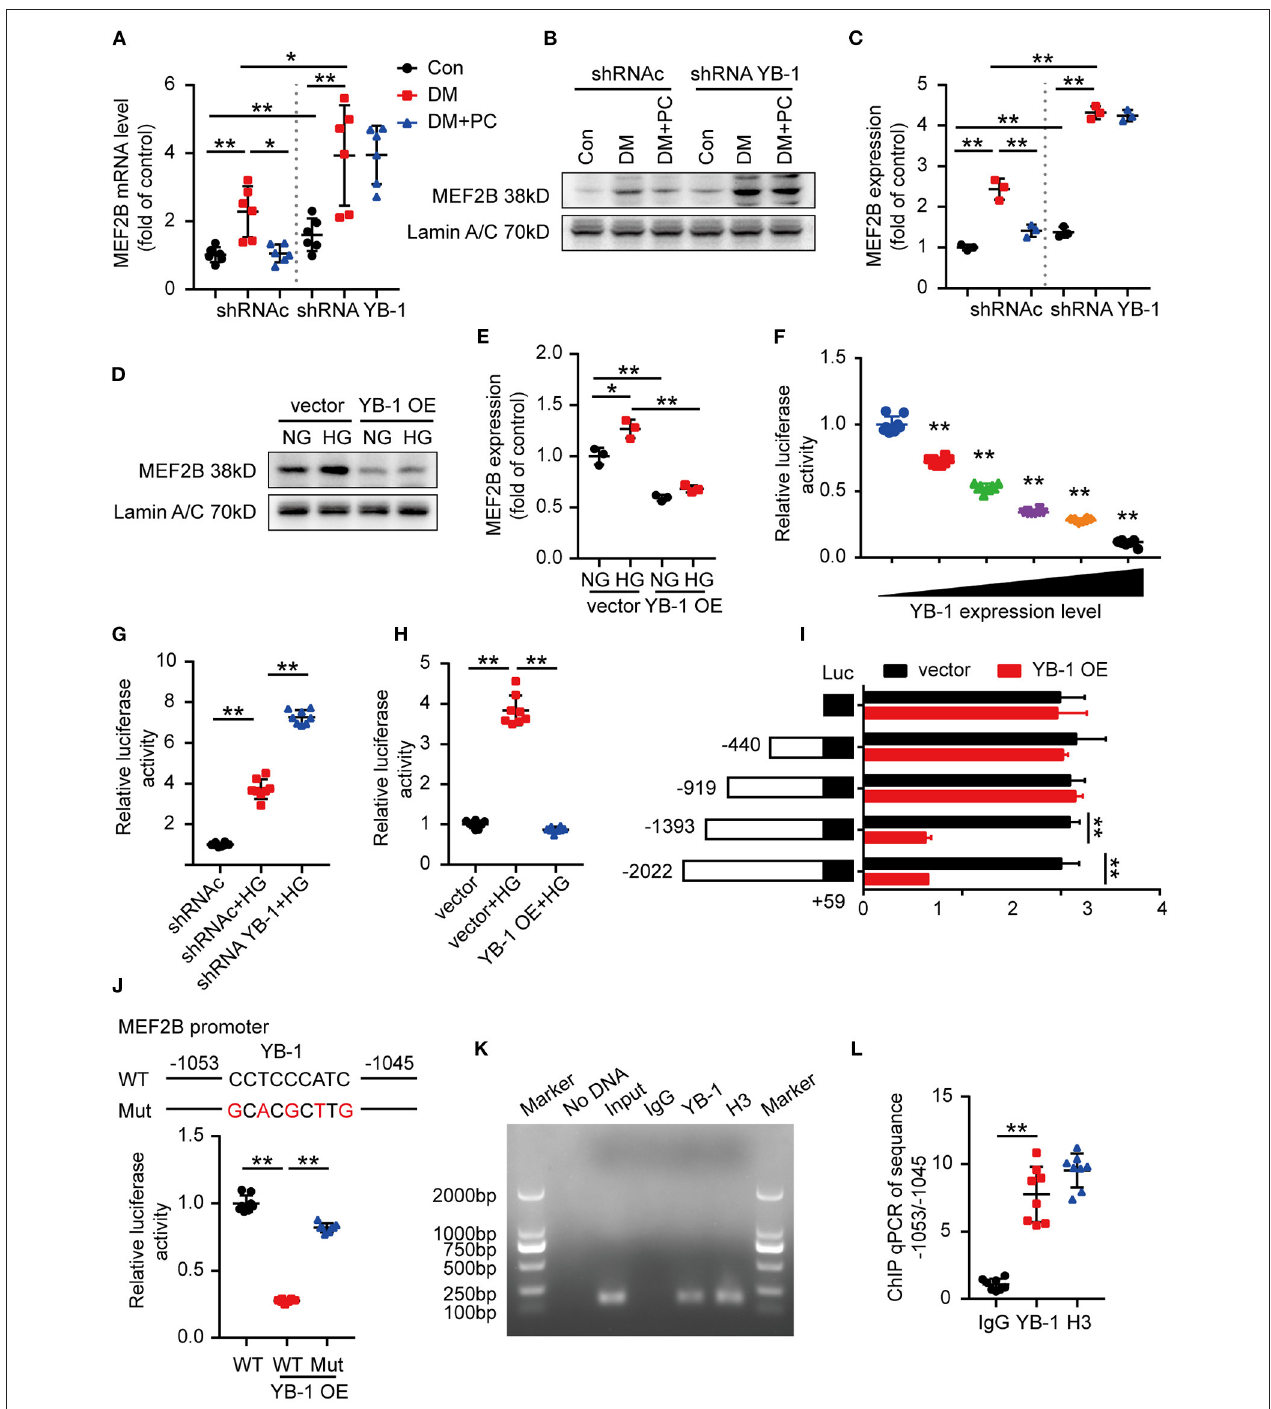
FIGURE 3 | YB-1 may regulate cardiac function via MEF2B. (A) MEF2B mRNA level in mouse heart tissues detected by real-time qPCR. n = 6 for each group. (B,C) Representative western blots and scatter blots showing MEF2B nuclear protein level in mouse heart tissues from indicated experimental groups. (D,E) Representative immunoblotting and scatter blots demonstrating MEF2B nuclear protein level in H9c2 cells with or without YB-1 overexpression. (B–E) n = 3 for each group. (F) Luciferase activity of pGL3-MEF2B-promoter reporter plasmids stimulated by various YB-1 overexpression degree in H9c2 cells. (G) Luciferase activity of pGL3-MEF2B-promoter reporter in YB-1 knock down H9c2 cells or scrambled shRNA lentivirus infected H9c2 cells, stimulated with HG or not. (H) Luciferase activity of pGL3-MEF2B-promoter reporter plasmids in YB-1 overexpression H9c2 cells or controls, stimulated with HG or not. (I) Luciferase activity of pGL3 ( − 2,022/ + 59), pGL3 ( − 1,393/ + 59), pGL3 ( − 919/ + 59), pGL3 ( − 440/ + 59), and pGL3-basic reporter plasmids stimulated by YB-1 overexpression in H9c2 cells. (J) Schematic